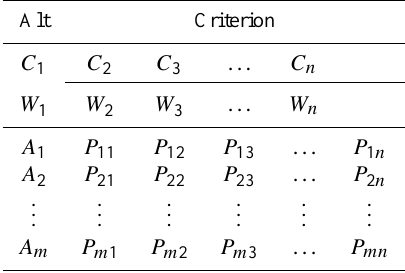
Table 4. Normalized decision